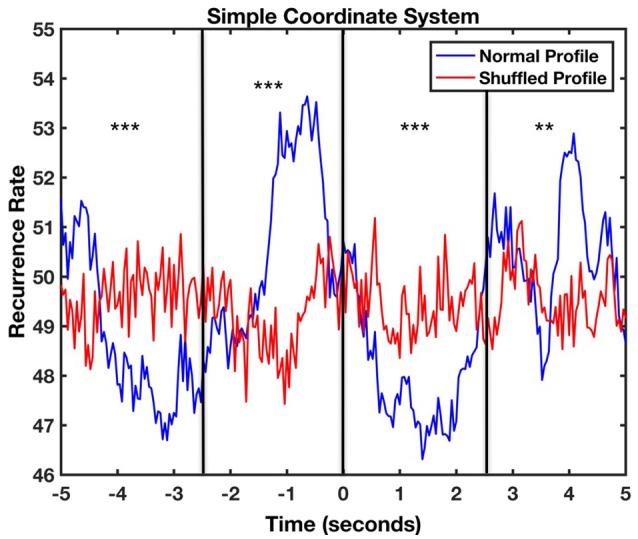
Lag profile between mother and infant body movements during the spinning toy task computed using diagonal-wise CRQA for the simple cosordinate system. The asterisks represent in which windows there were significant differences between the original recurrence profile with the shuffled one (**p < 0.01, ***p < 0.001).